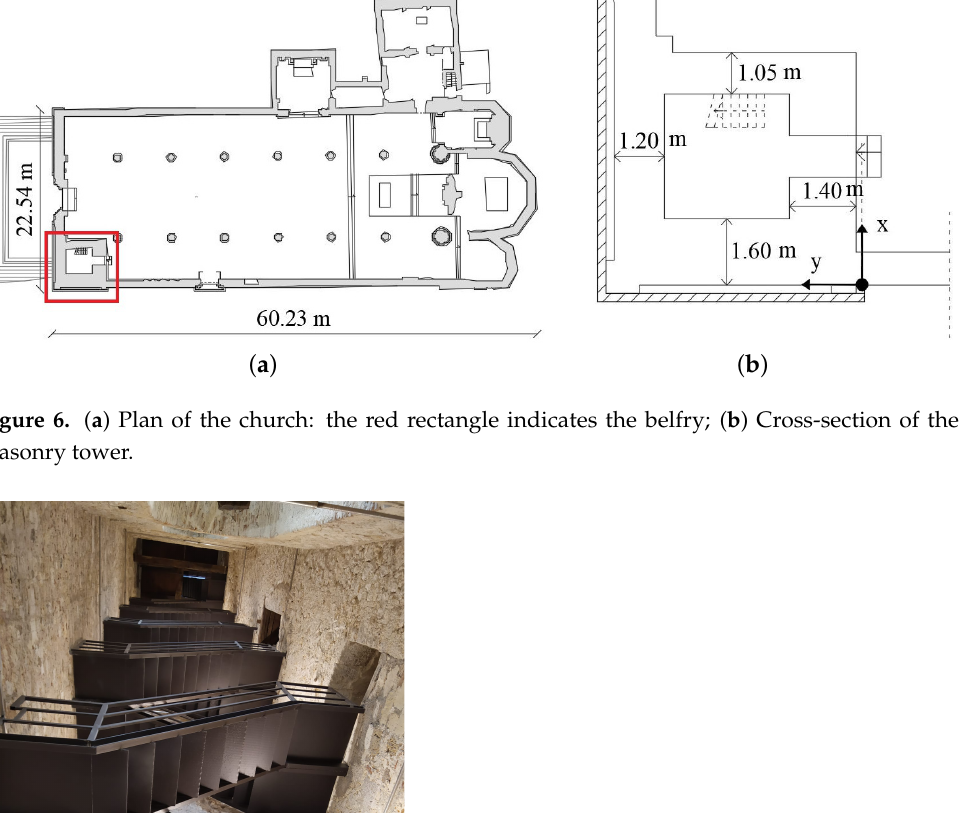
wall: 1.05, 1.20, 1.40 and 1.60 m, Figure 6b. The belfry was erected using rubble stone masonry